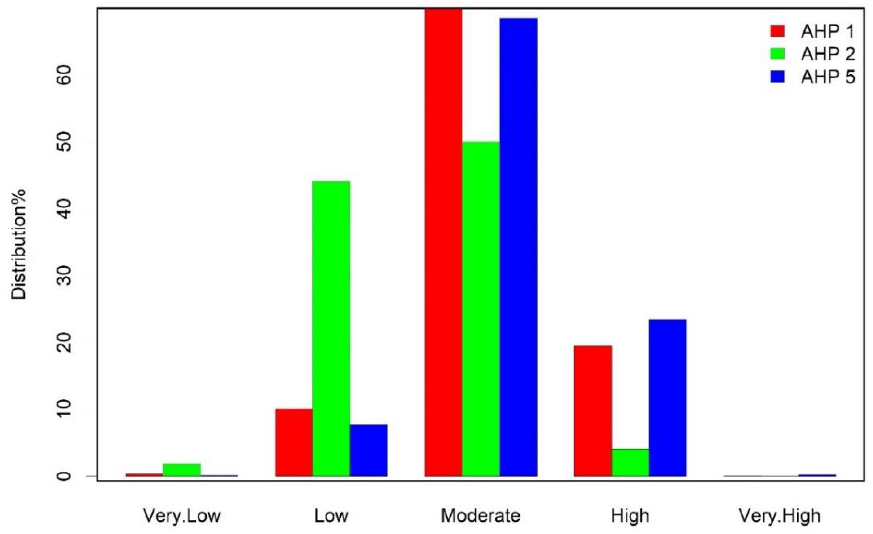
Figure 7. Bar graph showing the spatial suitability categories for CDCs in Al-Riyadh City. Table 6. The weights of the predictive factors suggested for the best three AHP models.